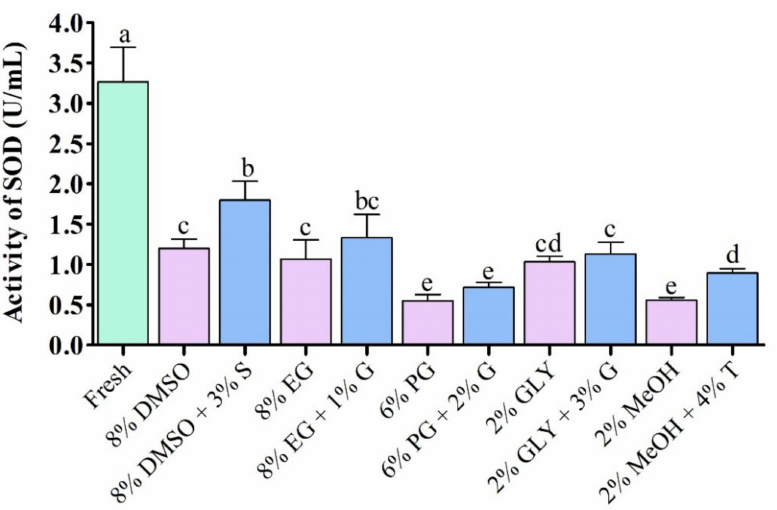
Figure 6. Enzymatic activities of superoxide dismutase (SOD) in different types of post-thaw sperm cryopreserved using saccharides. DMSO: dimethyl sulfoxide, EG: ethylene glycol, PG: propylene glycol, GLY: glycerol, MeOH: methanol, S: sucrose, G: glucose, T: trehalose. Results are presented as mean values ± standard deviation ( n = 10). Significantly different levels ( p < 0.05) are denoted by different